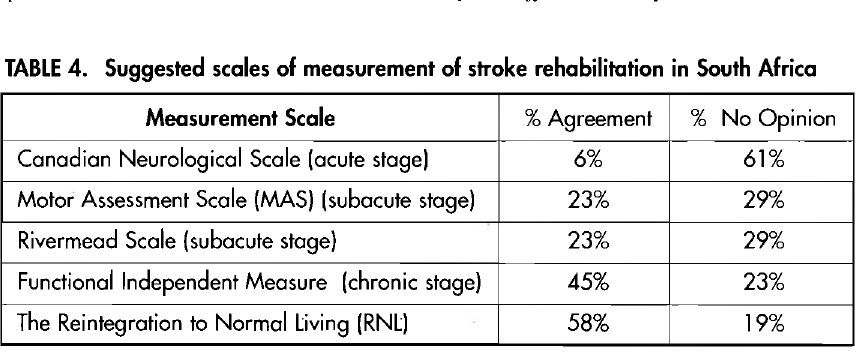
TABLE 4. Suggested scales of measurement of stroke rehabilitation in South Africa Measurement